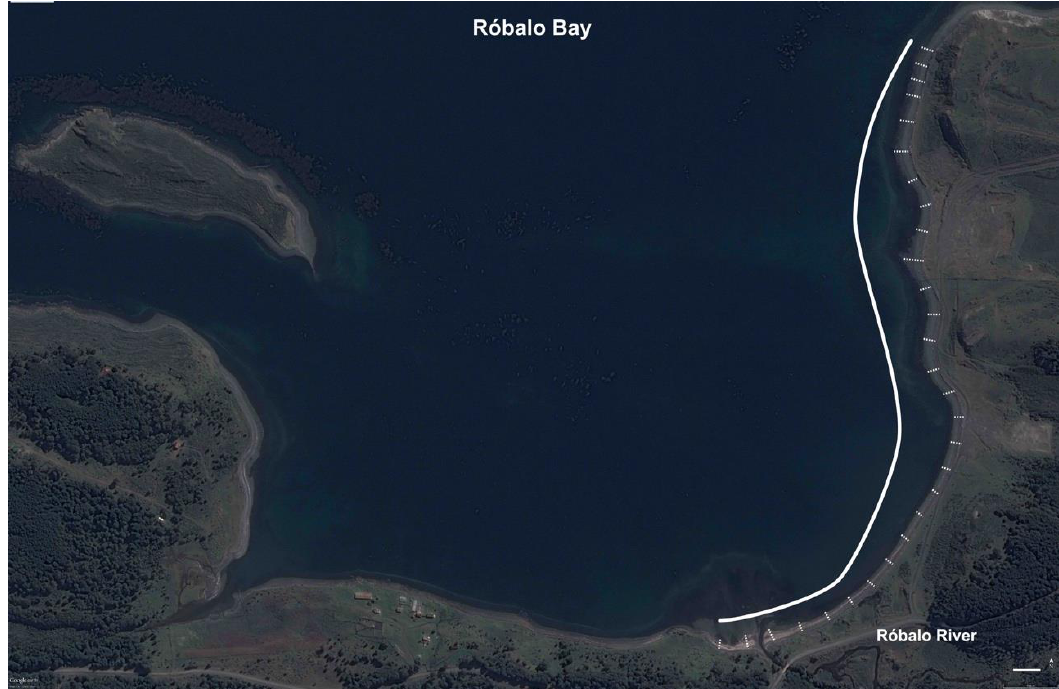
Figure 3. The location of the habitat transects at Róbalo Bay. Each transect included a quadrat (60 cm × 60 cm) deployed in the high-tide, mid-tide and low-tide zones of the shoreline. Satellite image edited from Google Earth (earth.google.com/web/).